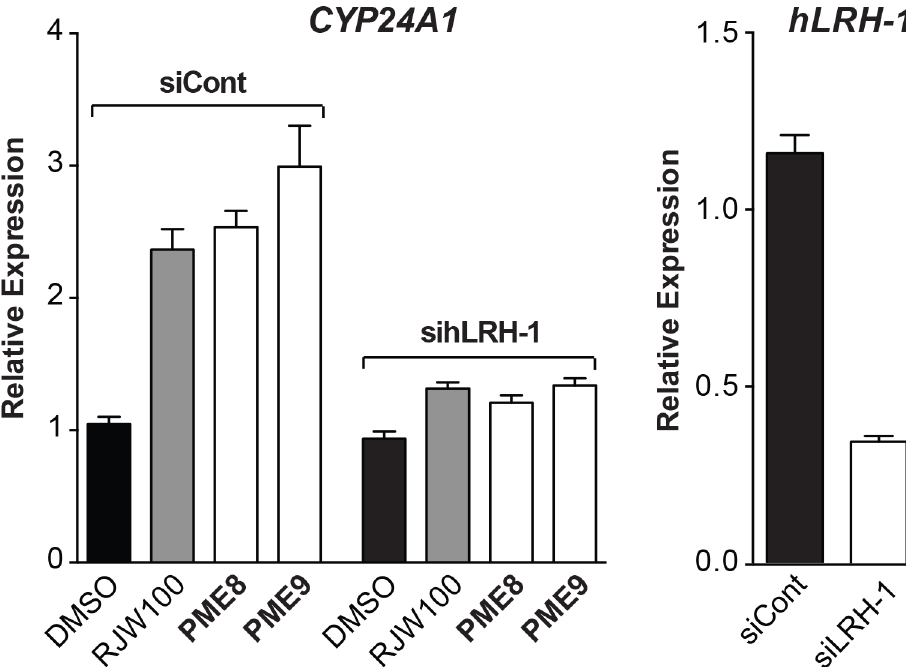
Fig 4. Activity of PME8 and PME9 Depends on hLRH-1. Expression of CYP24A1 transcripts was determined in the presence of RJW100 (grey bar) or the two new compounds PME8 and PME9 (10 μ M) without (siCont) or with knockdown (siLRH-1) of hLRH-1 (left panel). SiRNA-mediated knockdown of hLRH-1 in HepG2-hLRH-1 cells expressing low levels of hLRH-1 (-Dox) was carried out as described in Materials and Methods. Relative levels of hLRH-1 transcripts after siControl or sihLRH-1 are shown (right panel).